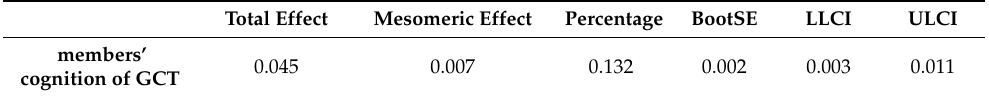
Table 9. Bootstrap tests for mediating